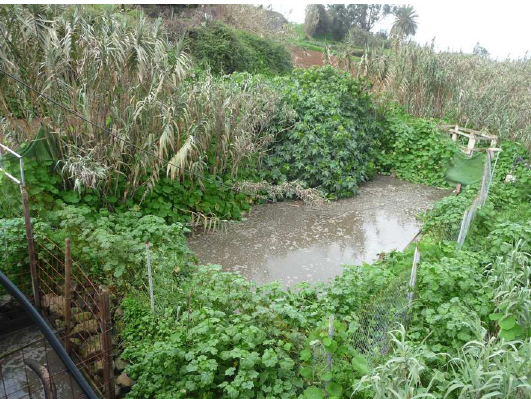
Figure 7. Photograph of Plant 3, with a detail of the rotary screen, and the anaerobic digesters.